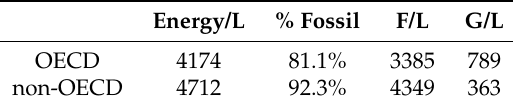
Table A4. Energy consumption